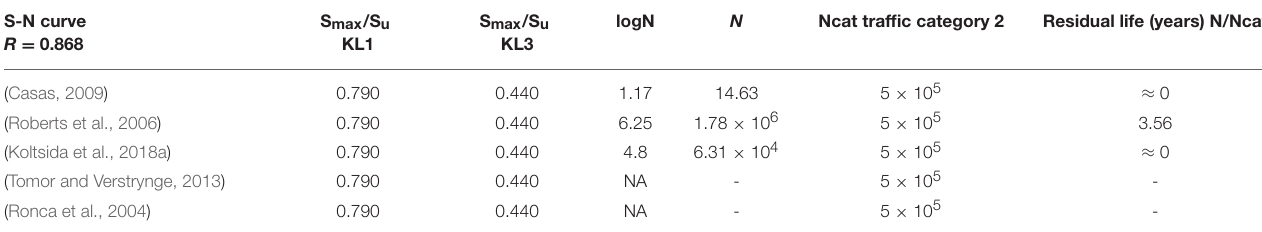
TABLE 4 | Residual service life evaluation of the secondary arches. S-N curve R =